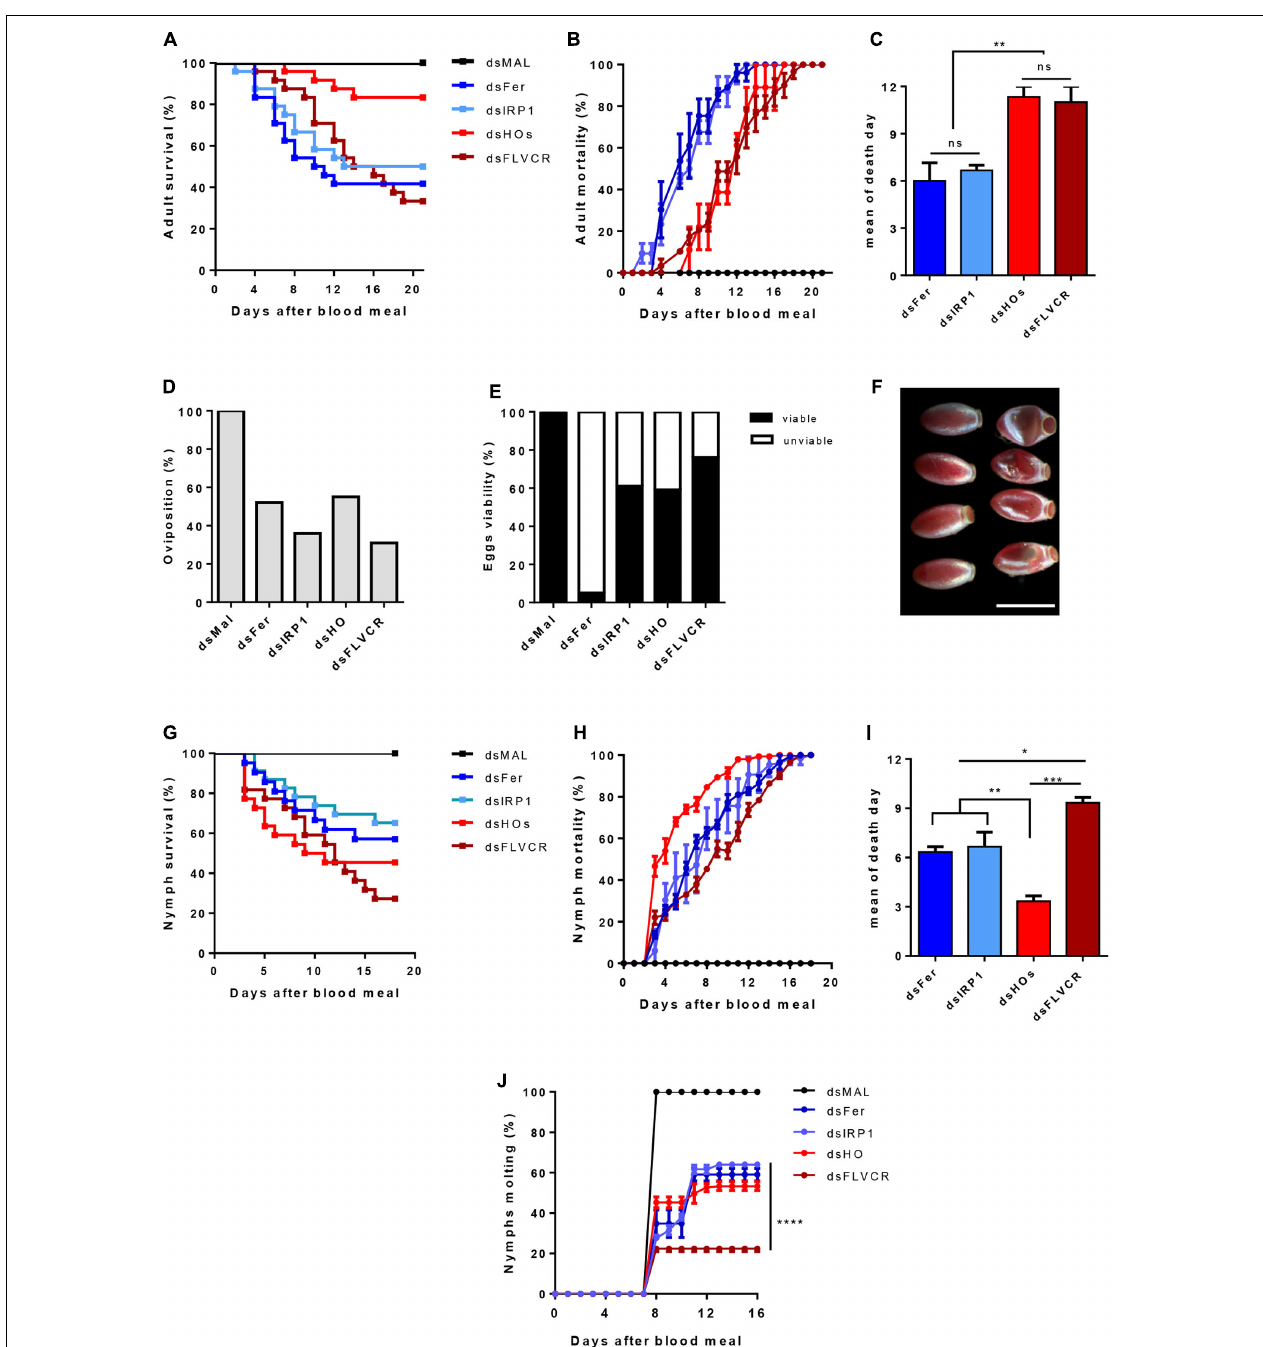
FIGURE 11 | The effect of iron/heme-related genes silencing in the insect physiology. Starved adult females were injected with 1 µ g of dsRNA of Ferritin (Fer), IRP (IRP1), Heme Oxygenase (HO) and FLVCR. After 48 h, the animals were fed on blood. The adults survival curves (A) oviposition (D) and eggs viability (E) were monitored for 21 days ( n = 24). Nymphs of the first instar (N1) were fed on blood supplemented with dsRNAs of the same genes. The nymphs survival curves (G) and the molting to the N2 instar (J) were monitored daily for 18 days ( n = 30). The survival curves data were replotted as % of total mortality of adults (B) and nymphs (H) to show the time course of silenced-insects mortality. The mean day of death of adults and nymphs are shown in (C,I) , respectively. Data shown in graphics are mean ± SE (F) Representative images of the phenotypic morphology of eggs laid by dsMal and dsFer-injected females (scale bar = 1,5 mm). dsMal-injected or fed insects were used as a control. Log-rank (Mantel-Cox) test was used for survival curves comparison, p < 0.0001 in (A) and p = 0,0001 in (G) . One-way analysis of variance followed by Tukey’s multiple comparison test was used to evaluate differences in the adults and nymphs mean death days, ∗ p < 0.01, ∗∗ p < 0.05, ∗∗∗ p < 0.001. Two-way analysis of variance followed by Tukey’s multiple comparison test was used to compare molting curves of nymphs fed with iron and heme-related dsRNAs and control group (dsMAL) ∗∗∗∗ p < 0.0001. All the experiments described above were independently performed at least three times.